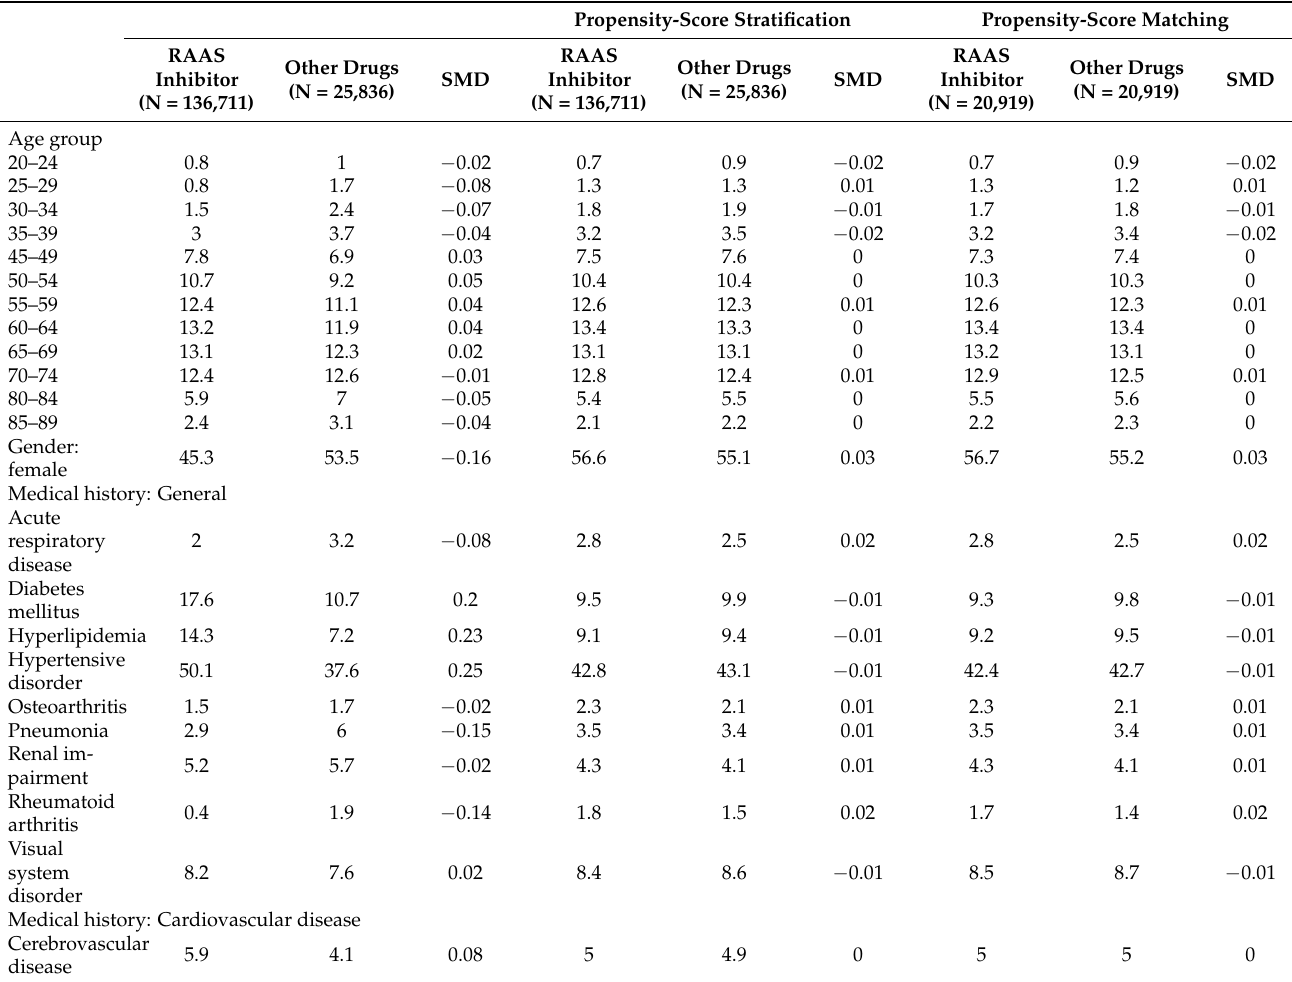
Figure 1. Study flowchart. Table 1. Baseline characteristics of cohort.